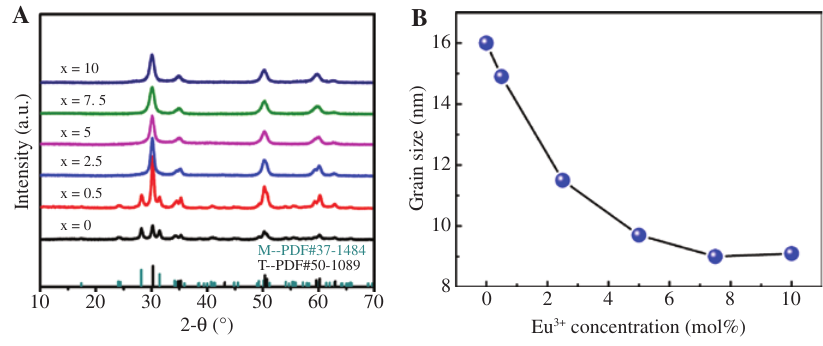
Figure 1: Characterization of phase structure. (A) XRD patterns of ZrO :Eu 3 + ( x mol%) nanocrystals. (B) Grain size vs. Eu 3 + doping 2